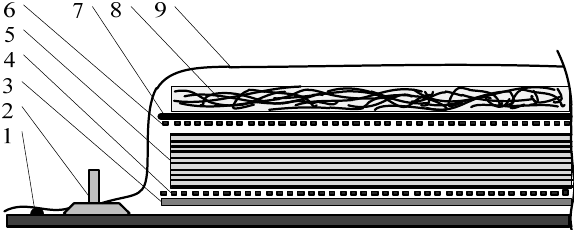
Figure 1: Scheme of the layup used in the processing: 1 sealant tape, 2 vacuum connector, 3 release film, 4 peel ply, 5 composite layup, 6 peel ply, 7 perforated foil, 8 bleeder, 9 vacuum bag.